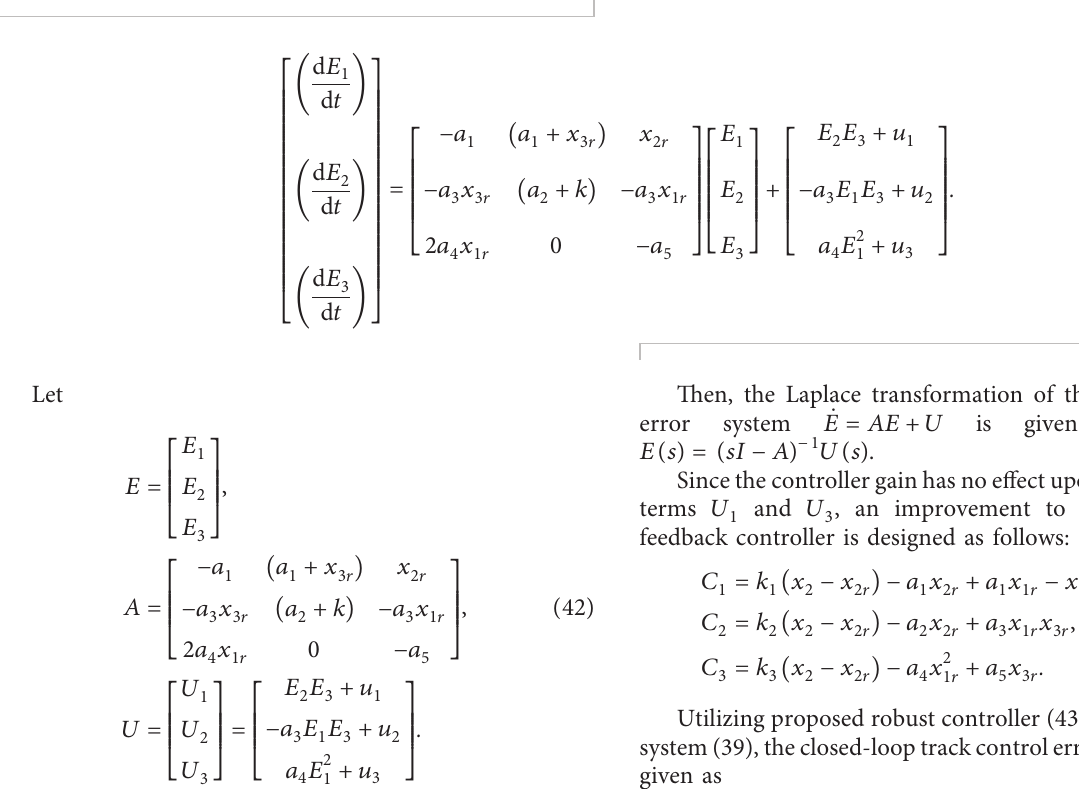
; (c) the state variable x 2